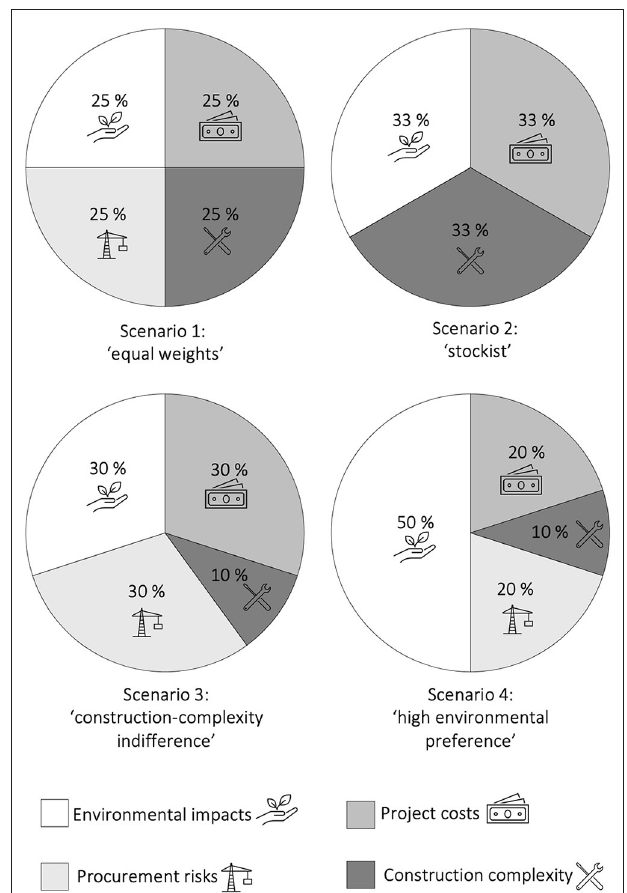
FIGURE 9 | Criterion weights for each preference